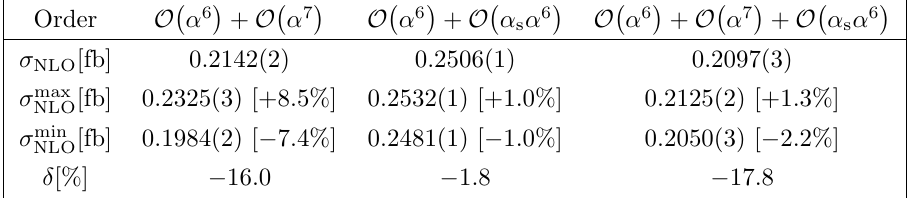
Table 3. Cross sections for pp (cid:22) + (cid:22) (cid:0) e + (cid:23) e jj+ X at the LHC with CM energy 13 TeV at NLO EW ! [ O Each contribution is given in fb (with the extrema resulting from scale variations as absolute numbers and as deviation in percent) and as relative correction (cid:14) = (cid:27) NLO =(cid:27) EW cross section of order in percent. The digits in parentheses indicate the integration errors. O instance diagram (cid:12)gure 1a with the lower up-quark line replaced by a bottom quark line), but are dominated by contributions of a resonant top quark. NLO cross sections including orders